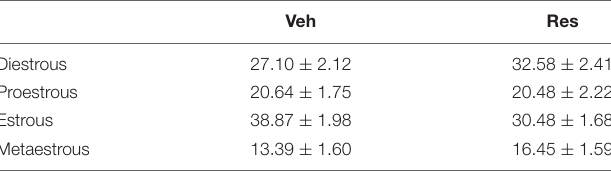
or vehicle-treated animals at the 10th [ r s ( 5 ) = − 0.564; p = 0.322] and 15th [ r s ( 8 ) = 0.204; p = 0.629) injections ( Figure 8